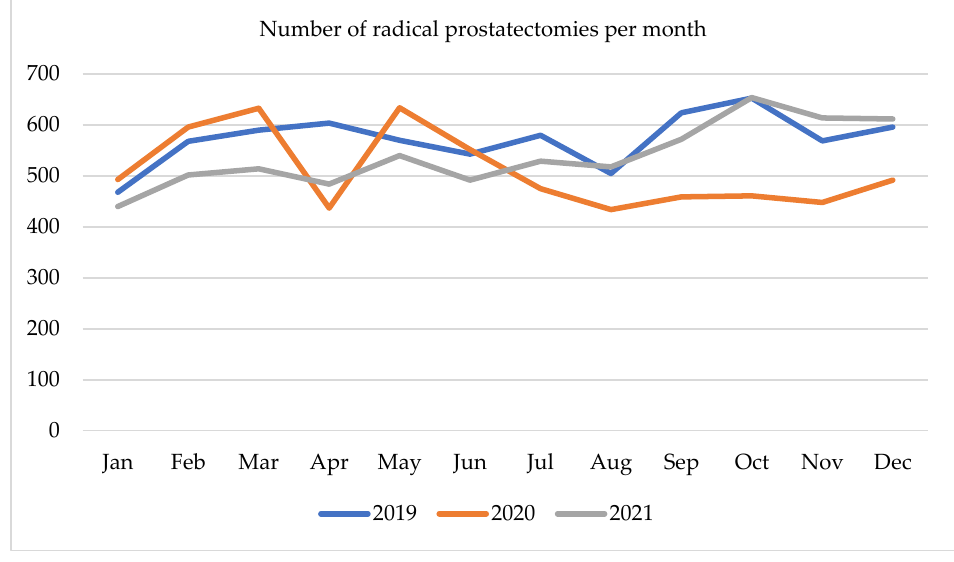
Figure 1. Number of radical prostatectomies per month in 2019 – 2021.